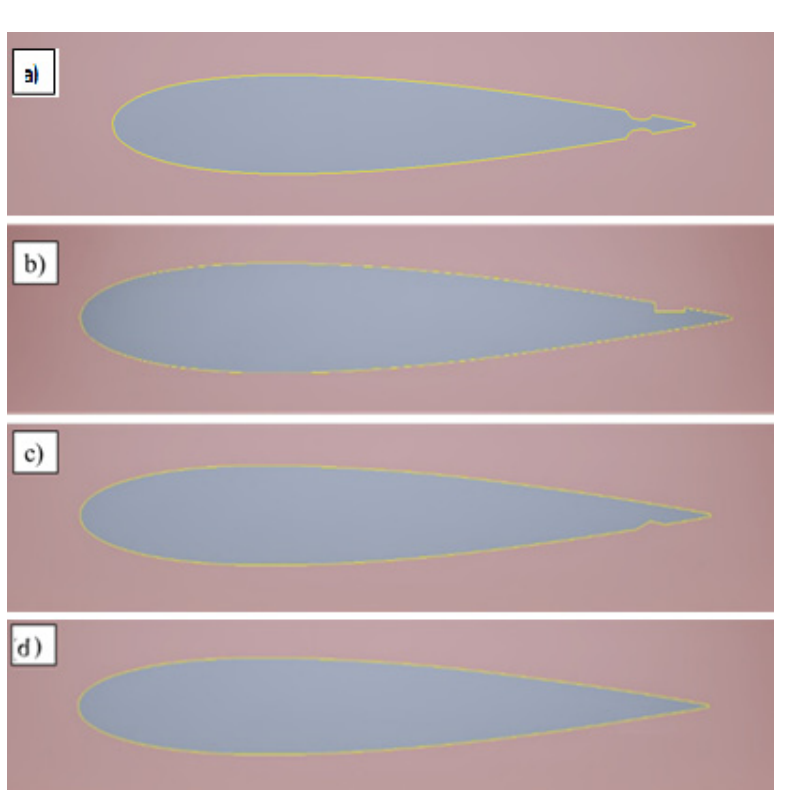
Figure 3. Geometry designs for different model, showing ( a ) elliptical dimples placed on the top and bottom of the aerofoil, ( b ) square dimple placed on top of the aerofoil, ( c ) triangular dimple underneath the aerofoil, and ( d ) no dimple aerofoil. Table 1. Details of the Freighter aircraft.